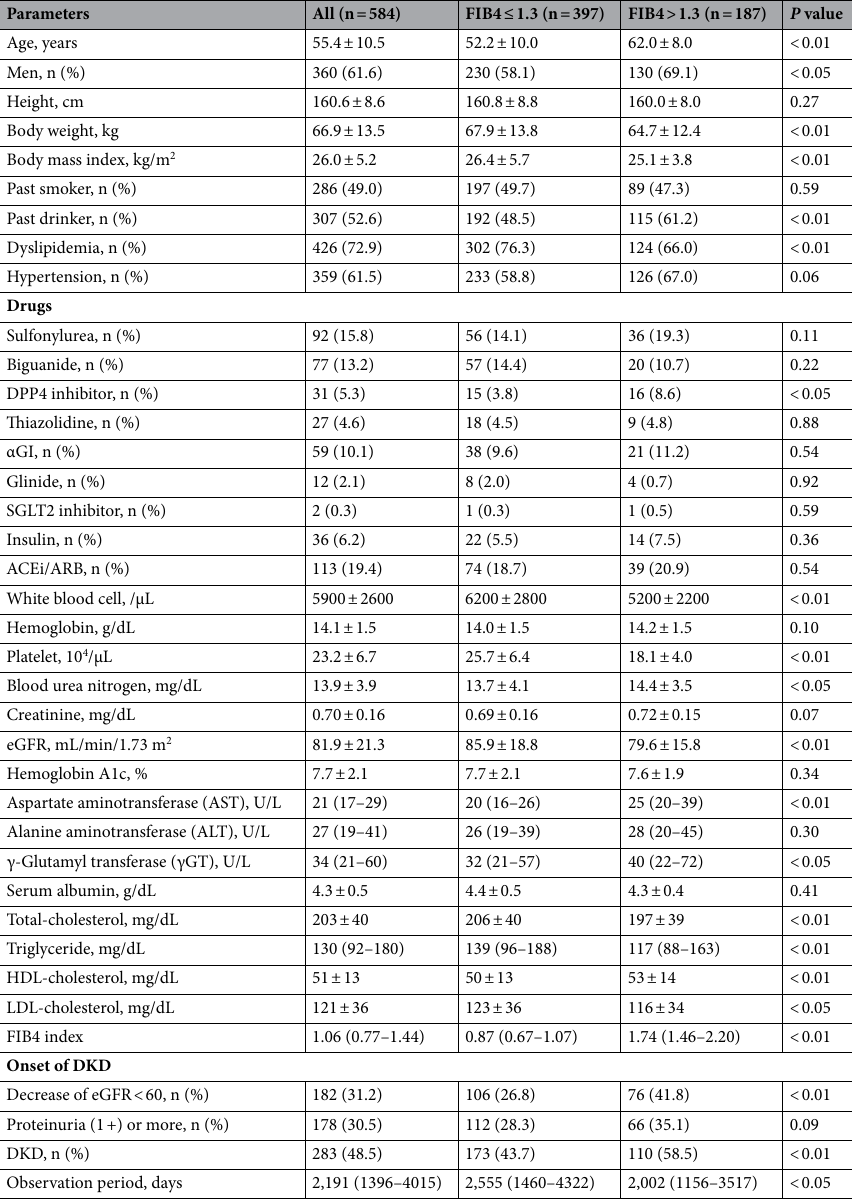
Table 1. Baseline characteristics of studied patients. Data is presented as mean ± SD, median (25–75th percentile), or percentages. DKD diabetic kidney disease, DPP4 Dipeptidyl Peptidase-4, αGI